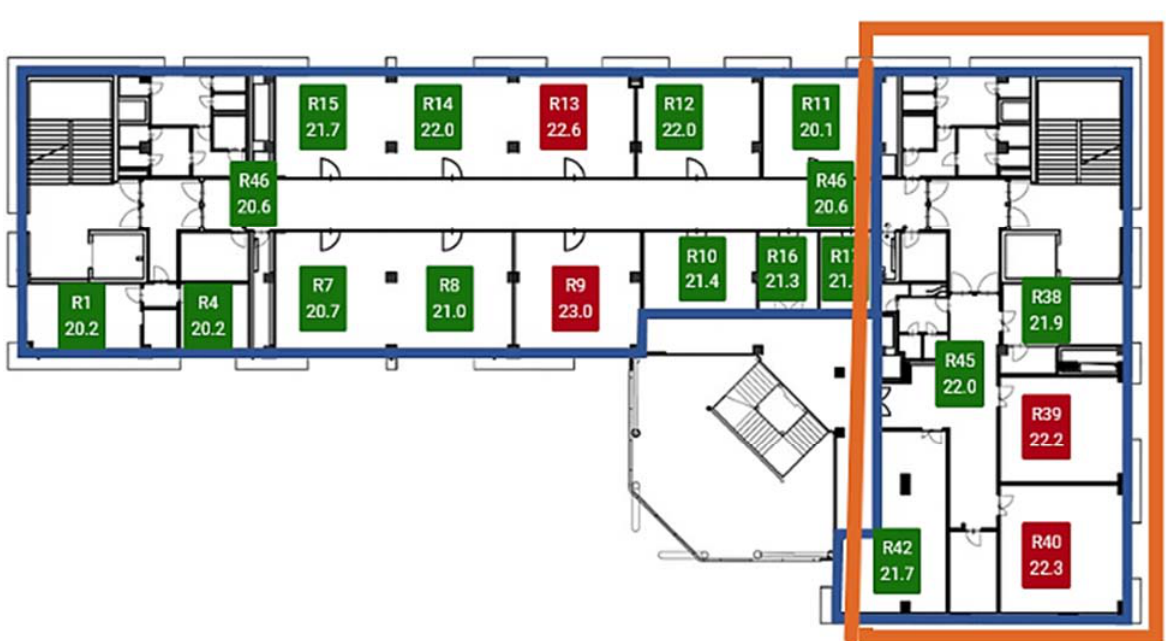
Figure 2. Energy Center layout. The layout is shared by all the considered floors. Green boxes indicate that the room set-point has been reached, red indicates a thermal discomfort situation with respect to the room set-point.